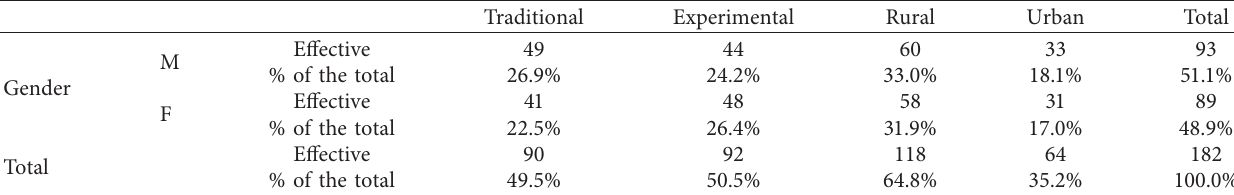
Table 1: Distribution of students by gender according to area and the method used.